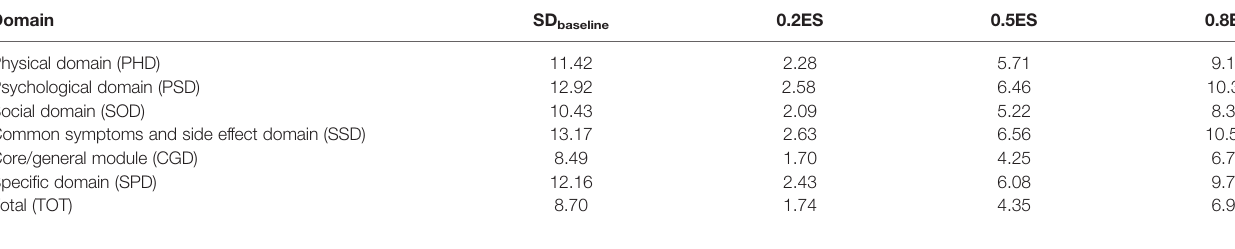
TABLE 4 | The MCID value of QLICP-BR (V2.0) determined by ES (n = 246).